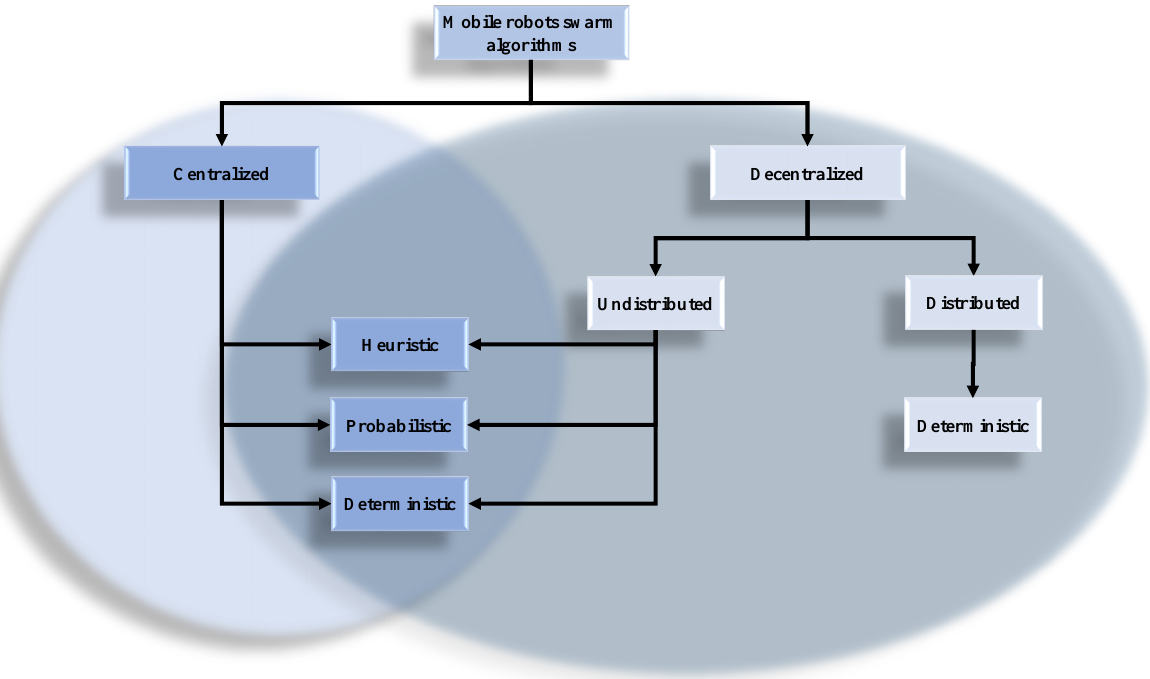
Figure 2. Taxonomy of algorithms for mobile robots